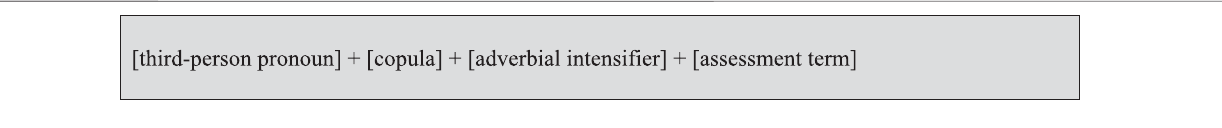
FIGURE 1 | The syntactic form of assessments in Finnish (from Rauniomaa 2007, p. 226).